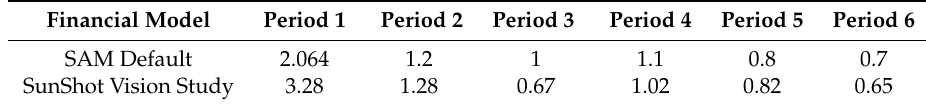
Table 5. Different Time-of-Delivery factors employed by SAM’s Default and SunShot Vision Study’s financial models.